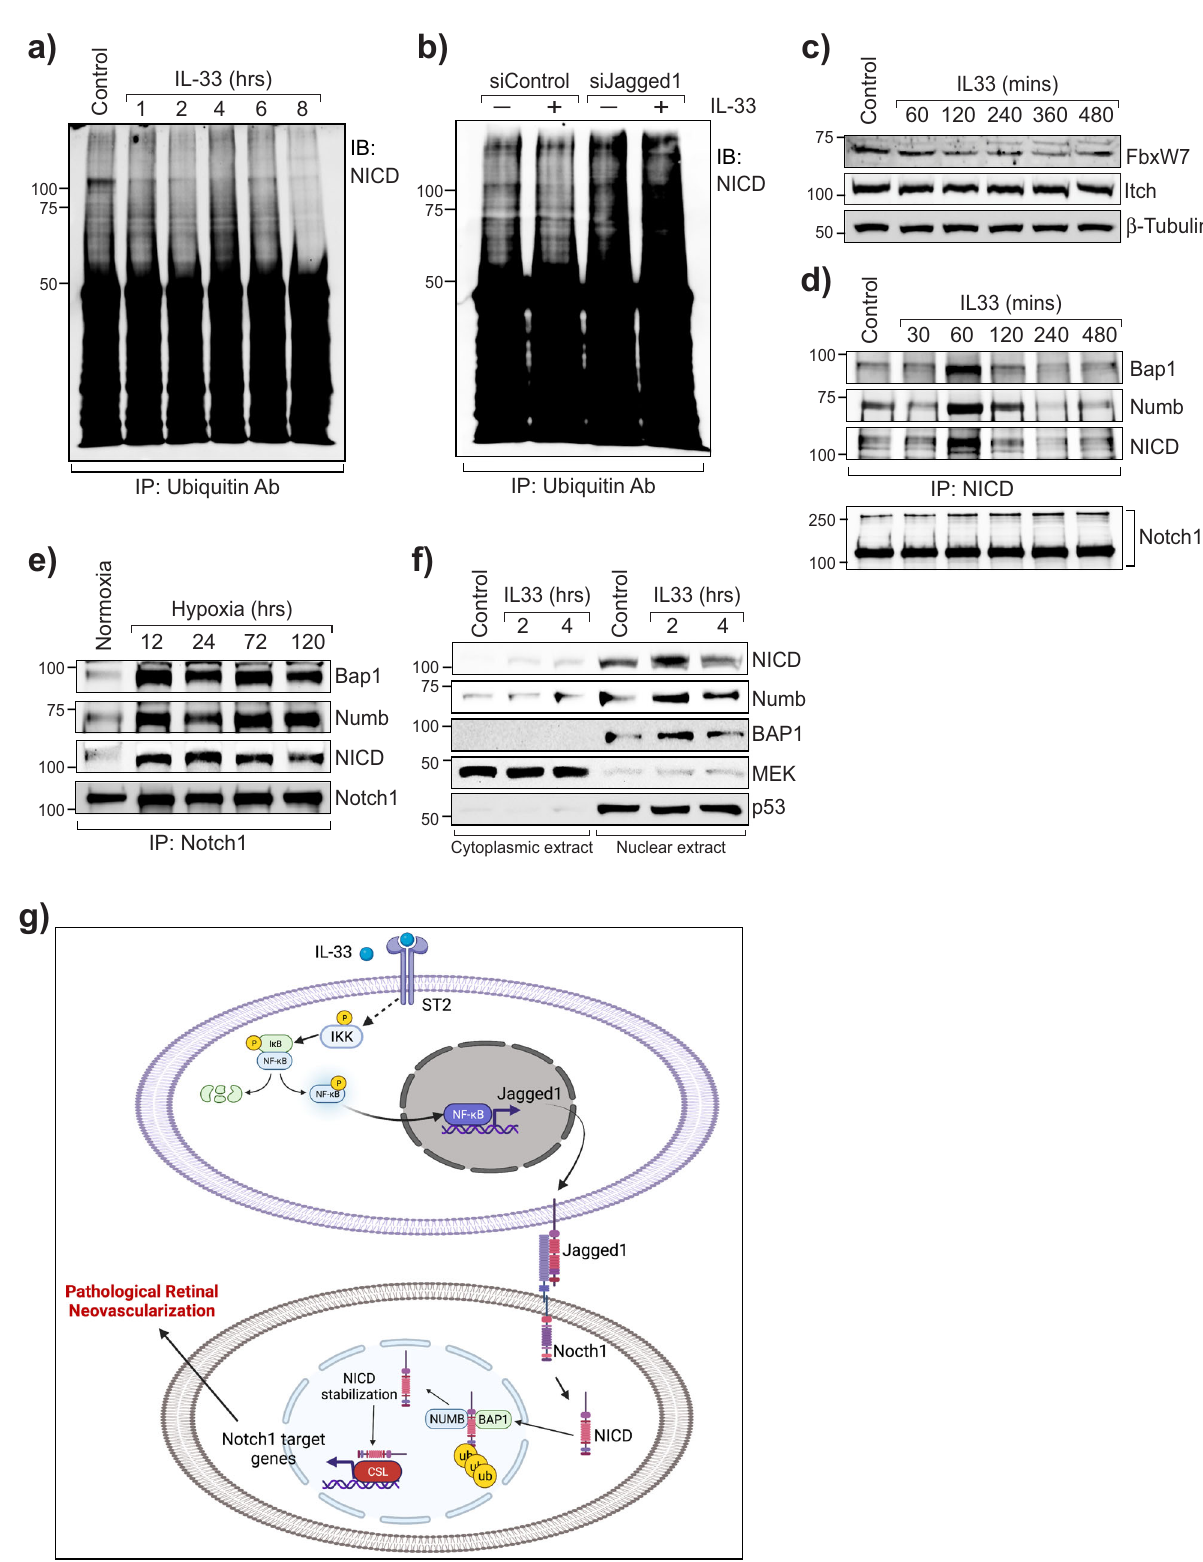
of the 7-AAD solution was added. Lastly, the HRMVECs were suspended in 1 mL of staining buffer. The samples were then analyzed using BD LSRII fl ow cytometer. Sprouting assay . HRMVECs three-dimensional sprouting assay was carried out using Cytodex 3 microcarrier beads 61 . The HRMVECs were transfected with the control and indicated siRNAs, trypsinized, and incubated with Cytodex